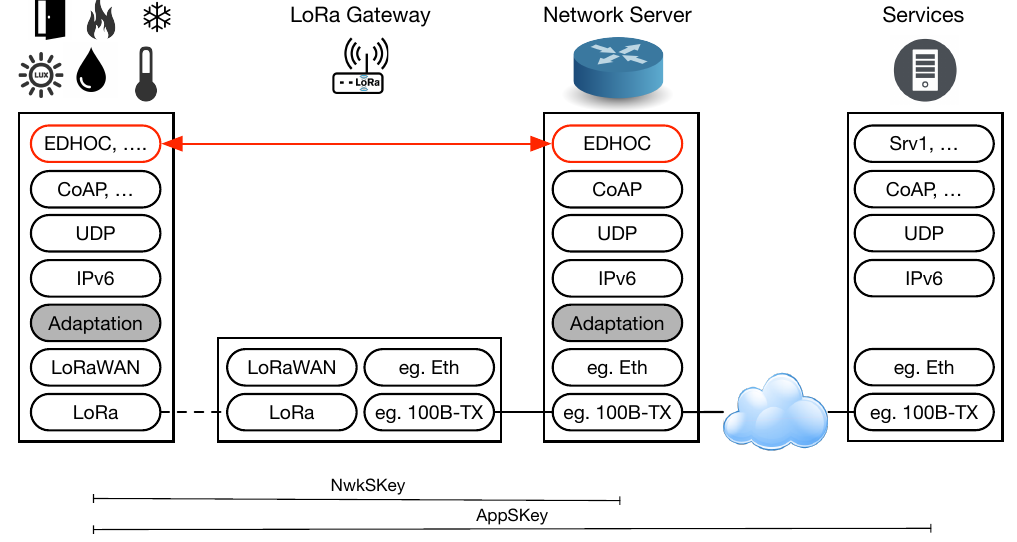
Figure 4. Architecture of the proposed security solution.